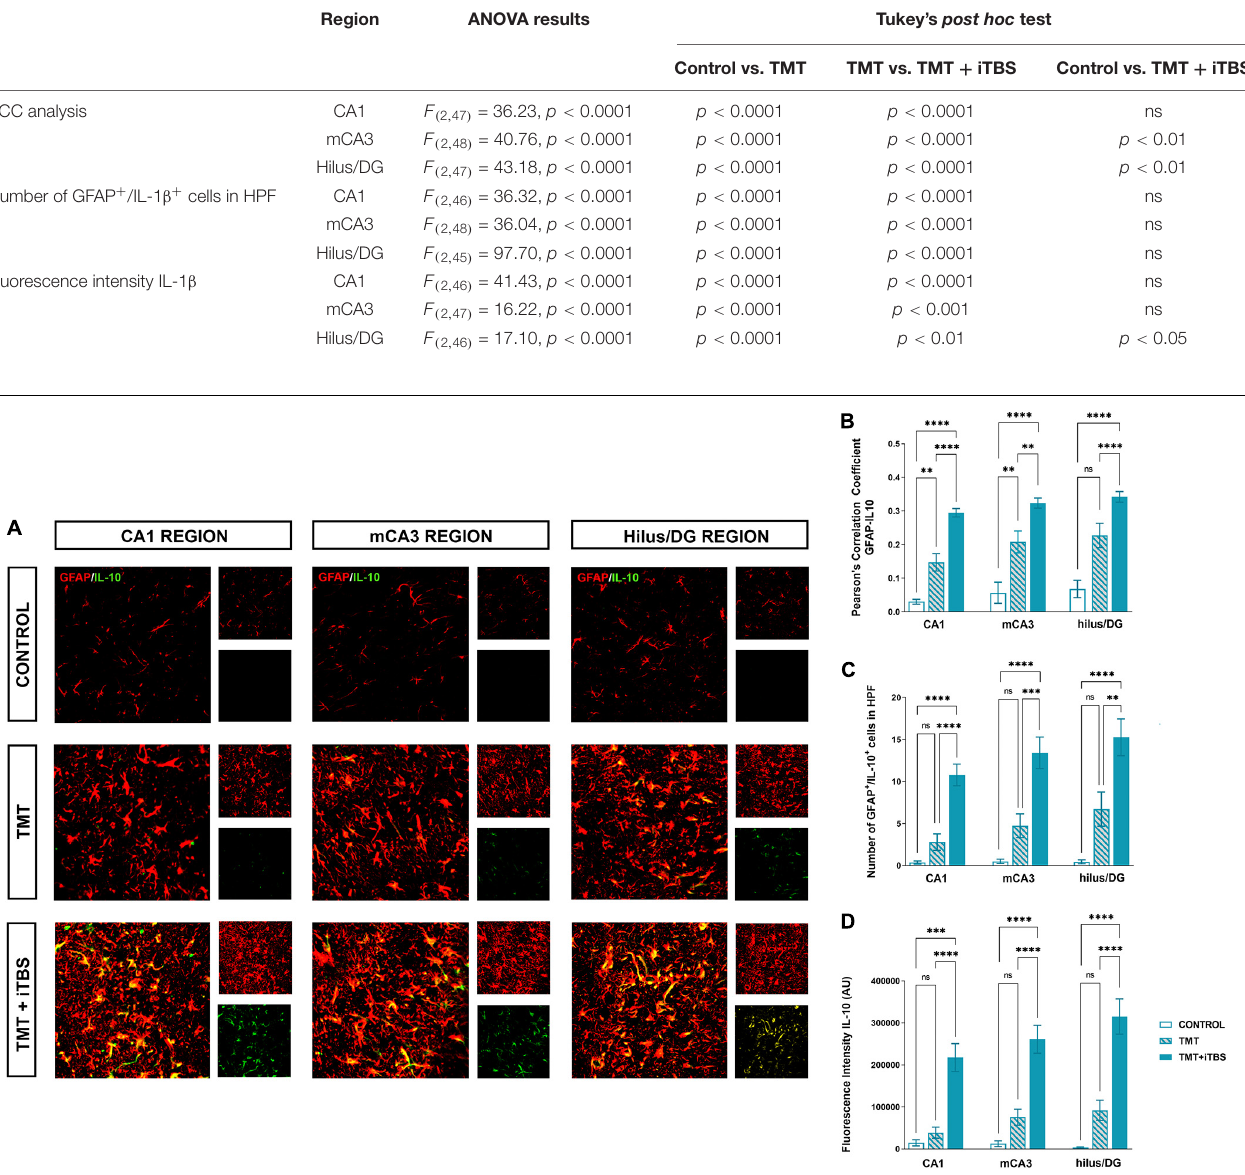
TABLE 2 | Results of one-way ANOVA analysis.